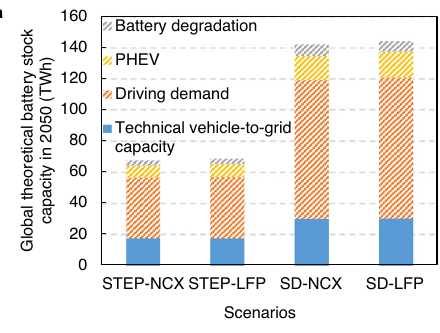
IRENAandStorageLabmodelsin2050(orangeshading).PleaseseeSupplementary Fig.16forglobalreal-worldvehicle-to-gridcapacityunderSTEP-LFPandtheSD-LFP scenarios and Supplementary Figs. 17 – 20 for regional real-world vehicle-to-grid